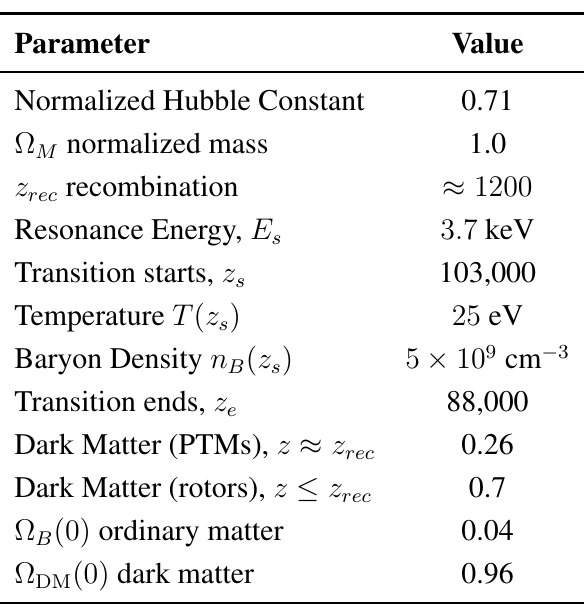
Table 2. Summary of the tresino transition evaluation